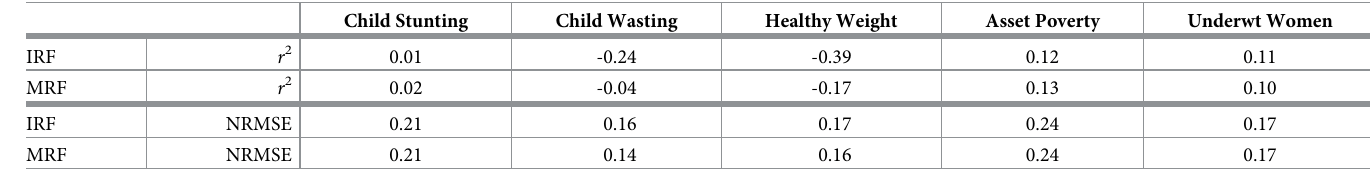
Scores are computed by taking a size weighted average of individual country level performance, with shared testing and training folds used across all